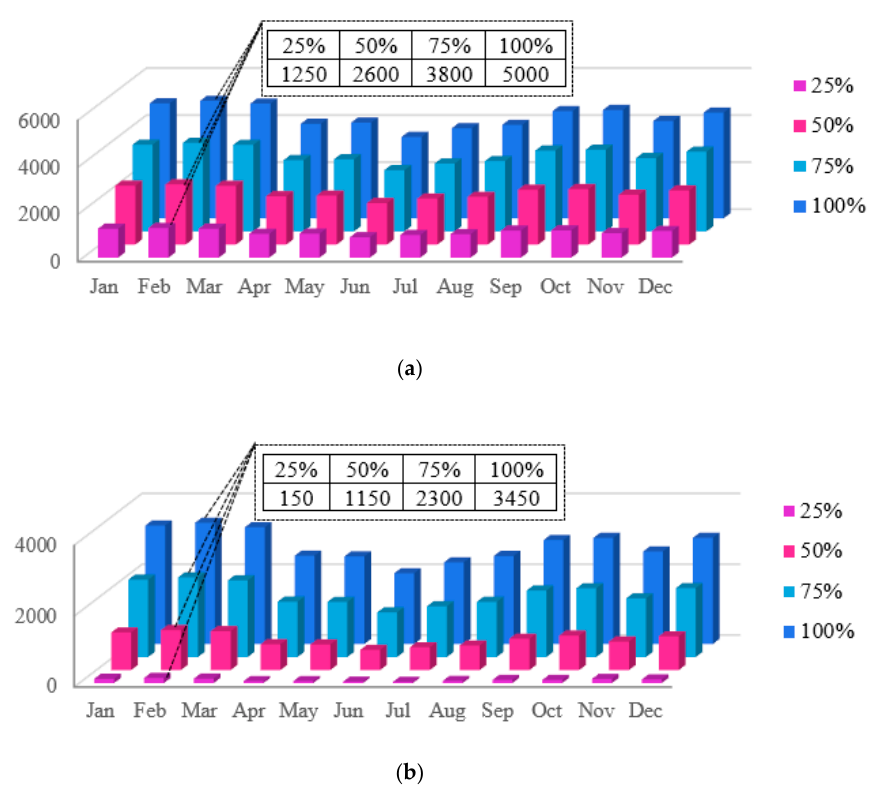
Figure 13. Comparison of BESS sizing within the year 2016: ( a ) PVGS and ( b ) RFPS. Table 4. BESS capacity and power rating for both strategies with a one year simulation period.